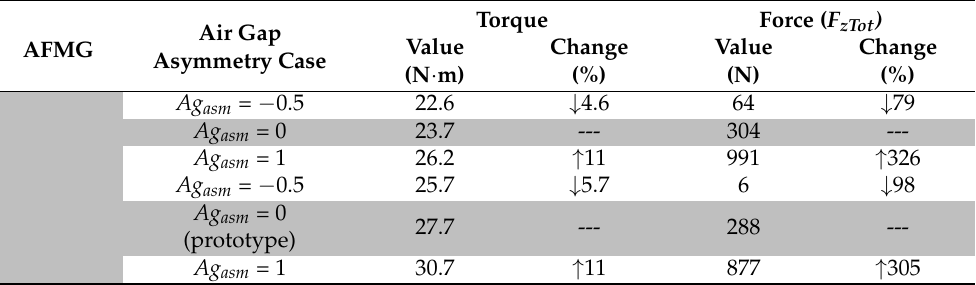
Table 2. Design parameters for the axial flux magnetic gears.